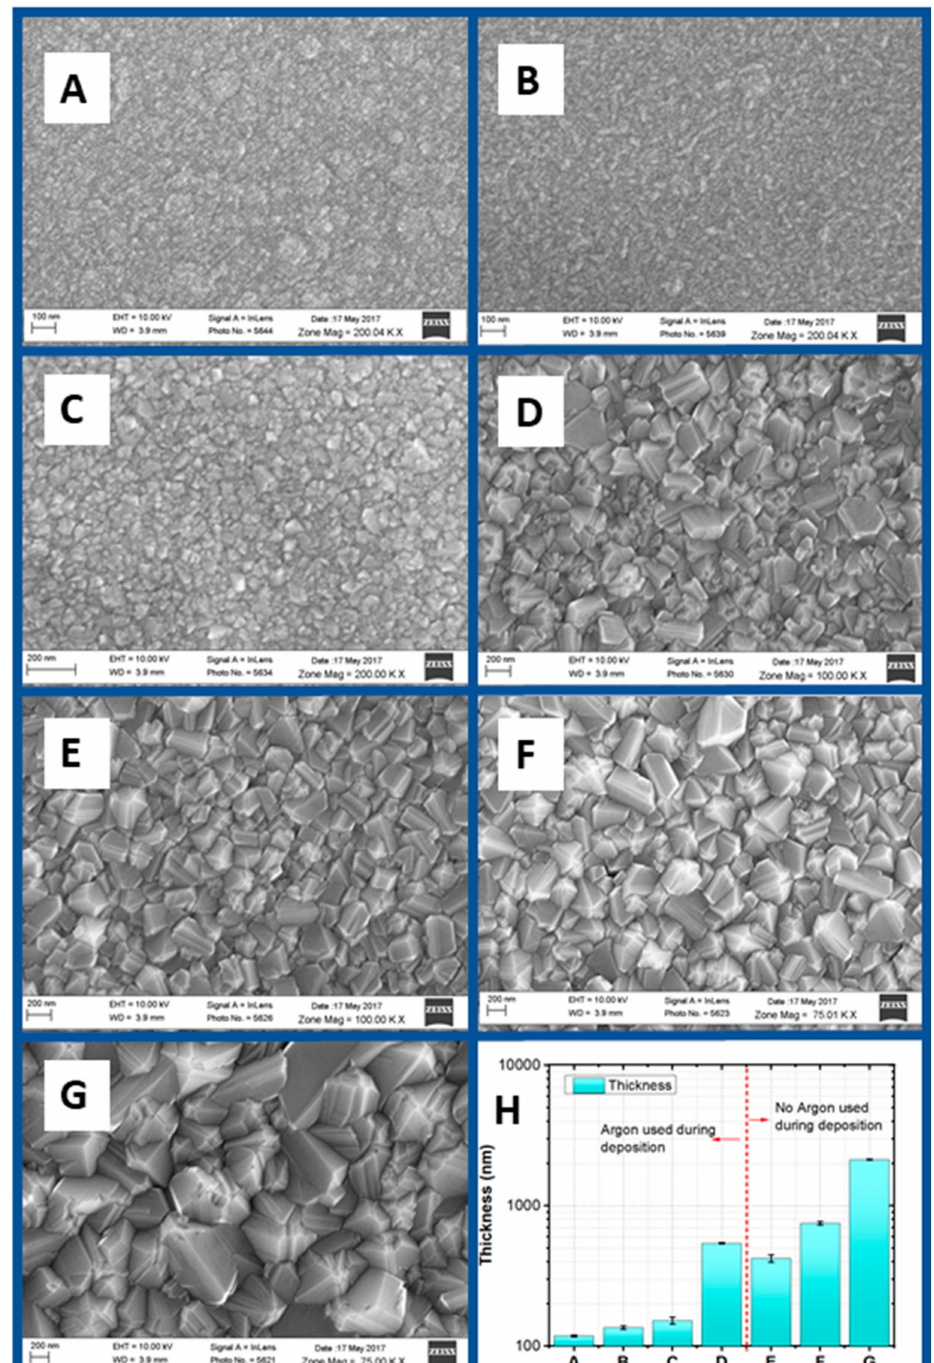
Figure 1. The morphology of the PCD films ( A – G in Table 1). ( H ) shows a plot of the grain size and the thickness of the films for samples